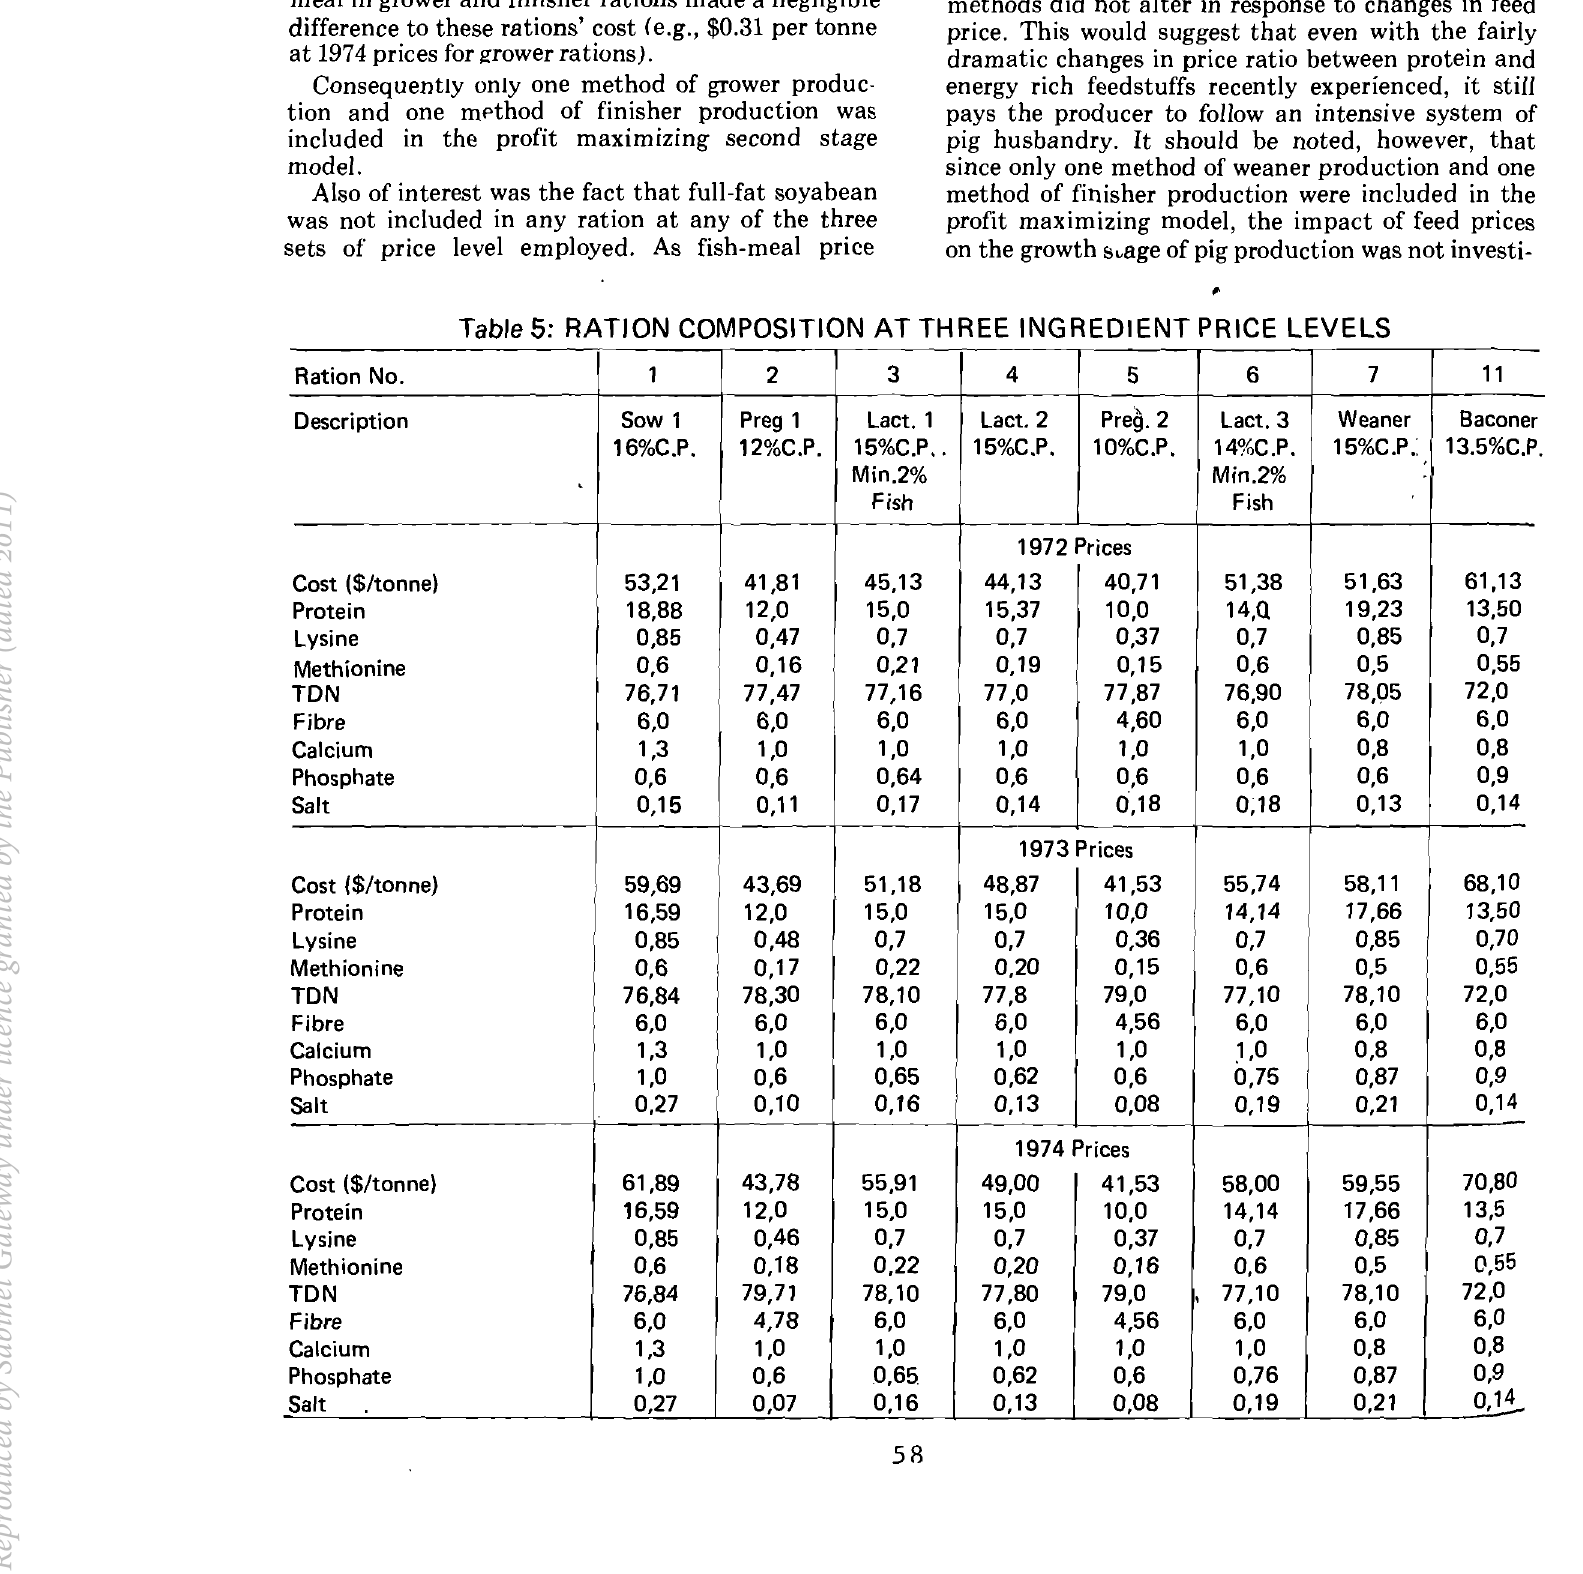
Table 5: RATION COMPOSITION AT THREE INGREDIENT PRICE LEVELS Ration